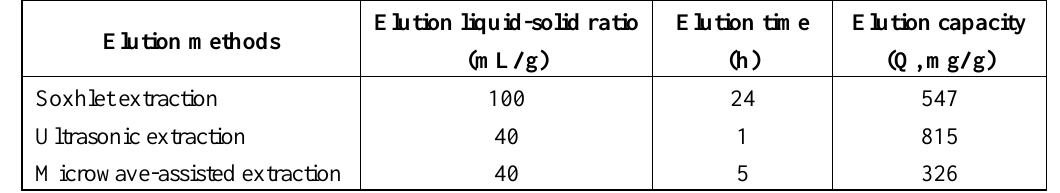
Table 1. Conditions and yield of the extraction processes tested for removal of rutin from MIPs. Reproduced from Peng et al. [63] with permission from the Royal Society of